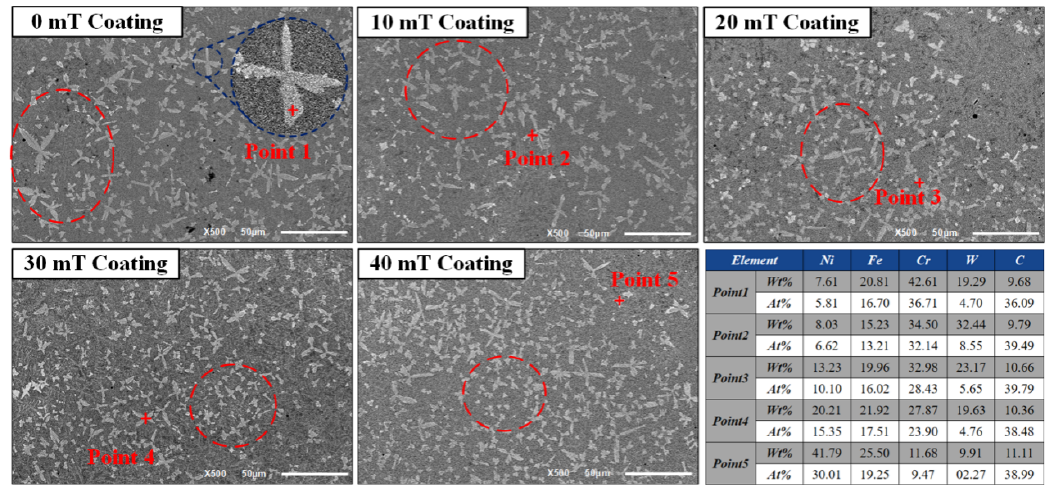
Figure 4. SEM images of middle regions of coatings and element composition at different points on the surface of coatings.